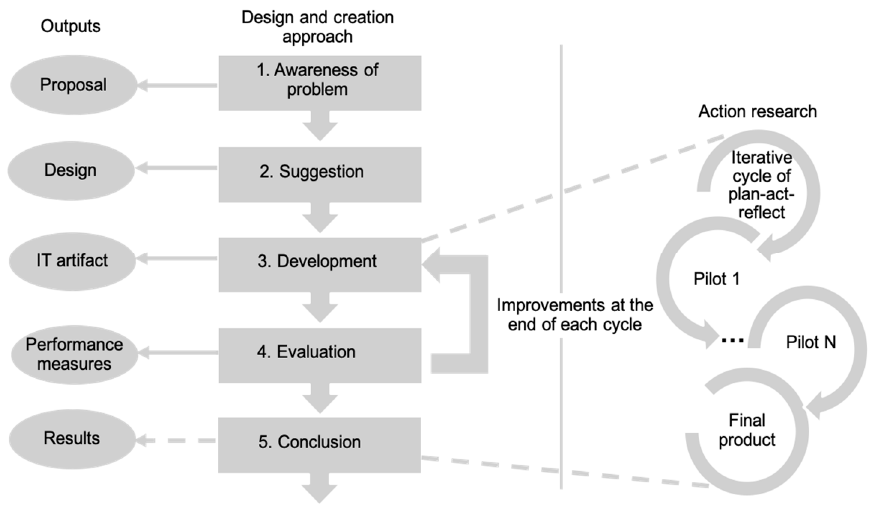
Figure 1. Research methodology.